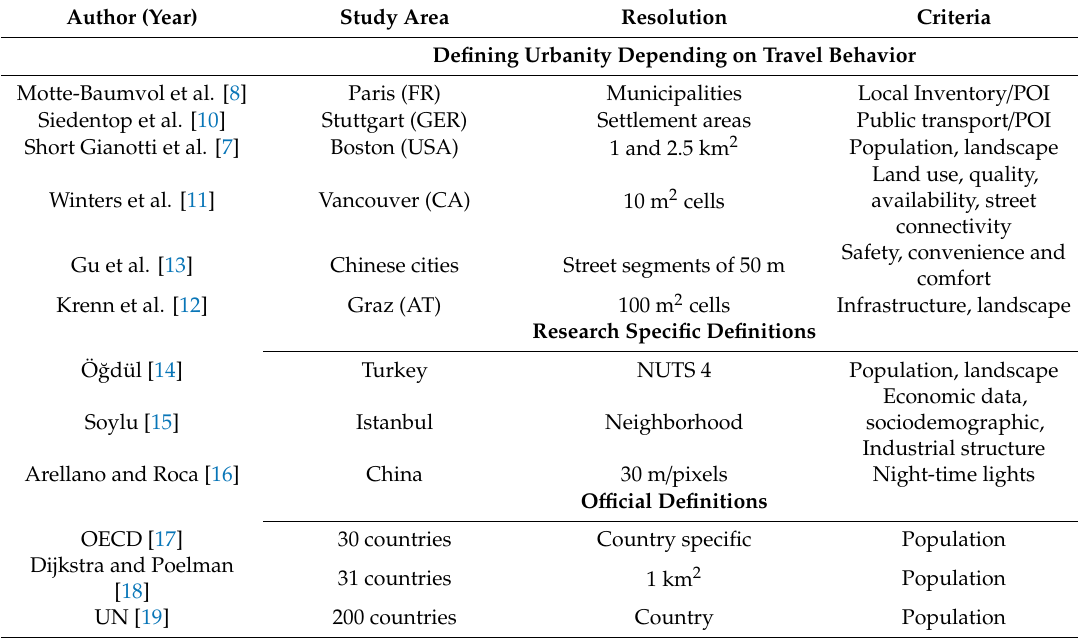
Table 1. Overview of literature in the context of defining